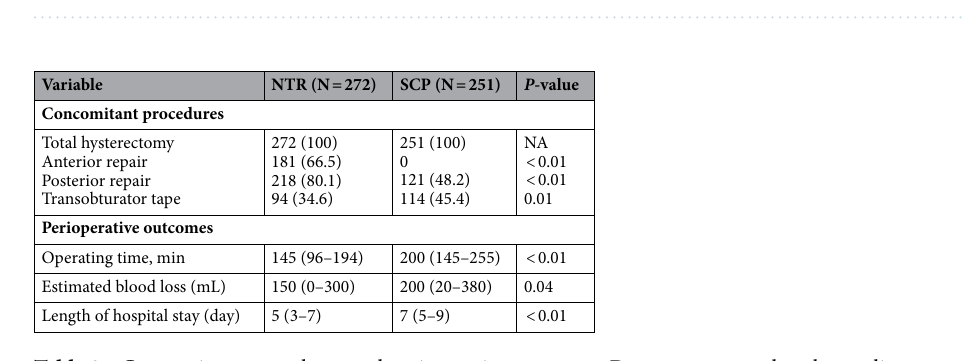
Table 2. Concomitant procedures and perioperative outcomes. Data are presented as the median (interquartile range) or number (%). NA, not applicable; NTR, native tissue repair; SCP, sacrocolpopexy.